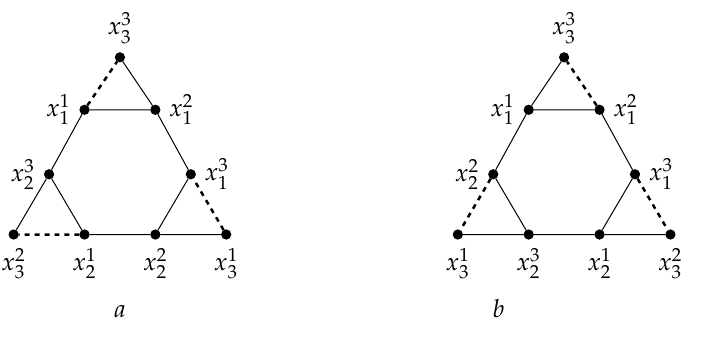
Figure 2. ( a ) |{ w 3 , w 6 } ∩ Y 3 | = 2, ( b ) |{ w 3 , w 6 } ∩ Y 3 | =